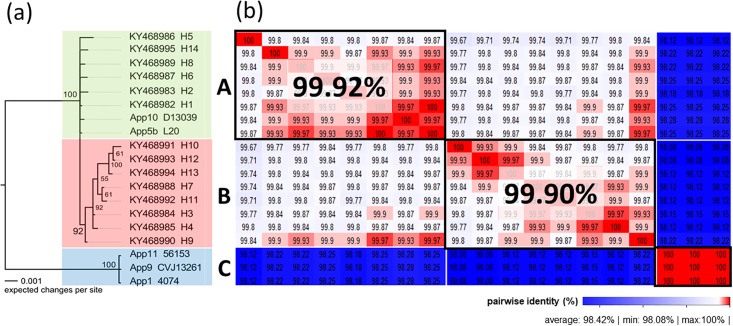
Consensus tree (2a) and the heatmap distance matrix of pairwise comparisons (2b). a The phylogenetic tree (Fig 2a) obtained by the Bayesian analysis of the 60 sequences of the apxIA gene of A. pleuropneumoniae serovar 5 isolates of swine from different Brazilian states, plus five isolates from the GenBank database. The posterior probability values (PP) (expressed as percentages) calculated using the best trees found by MrBayes are shown beside each node. Clades were divided by identity into three monophyletic clades: green clade (A), red clade (B), and blue clade (C). b The heatmap distance matrix (Fig 2b) represents high nucleotide identity in red and low identity in blue, and together with the phylogenetic tree identifies the clades in groups of major/minor identity, surrounded by squares with black edges, indicating the actual percentage of identity.